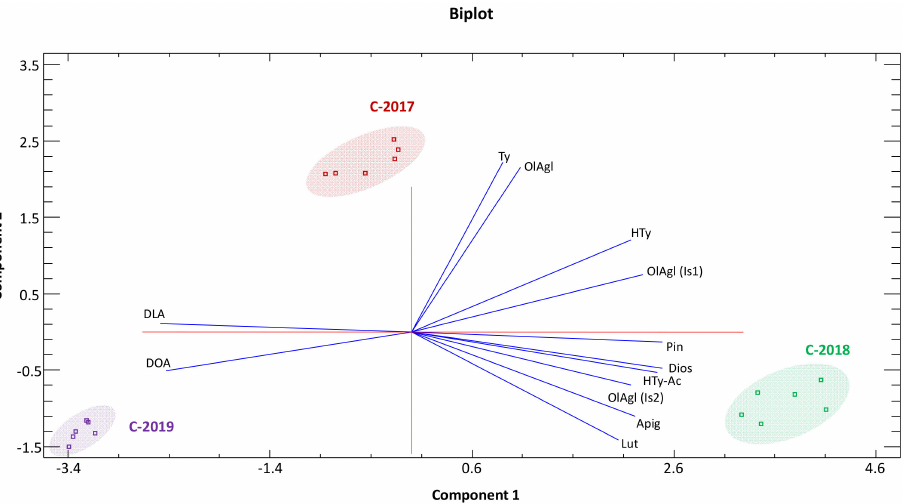
Figure 1. Distribution of ‘Mansa de Figueiredo’ EVOOs in a biplot system defined by the first two principal components (Component 1 vs. Component 2). C-2017: EVOOs from 2017 campaign; C-2018: EVOOs from 2018 campaign; C-2019: EVOOs from 2019 campaign. Loadings are shown as vectors.